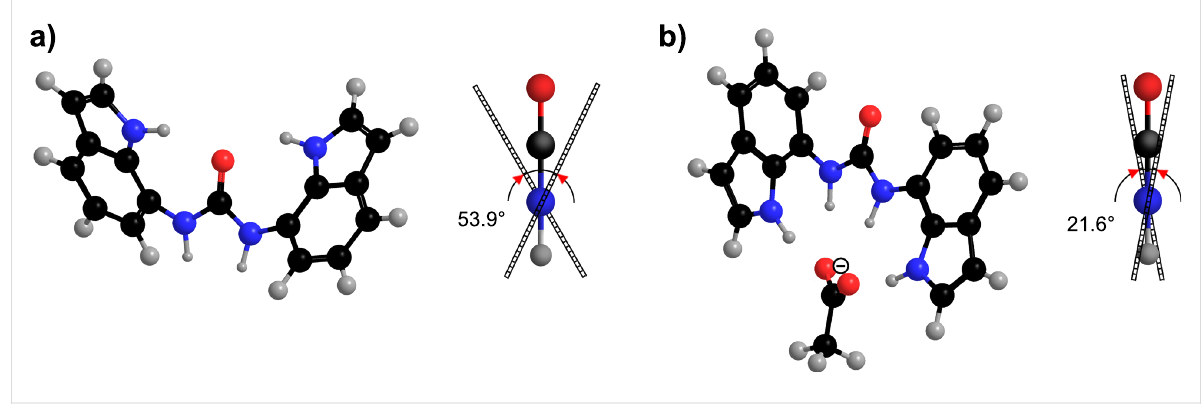
Figure 6: Freely optimized structure at the B3LYP/6-311+G(d,p) level of theory and side view showing deviation from coplanarity defined by the angle between the indolyl rings of receptor 1 in the absence of anions (a) and for the 1 ·AcO − complex (b).